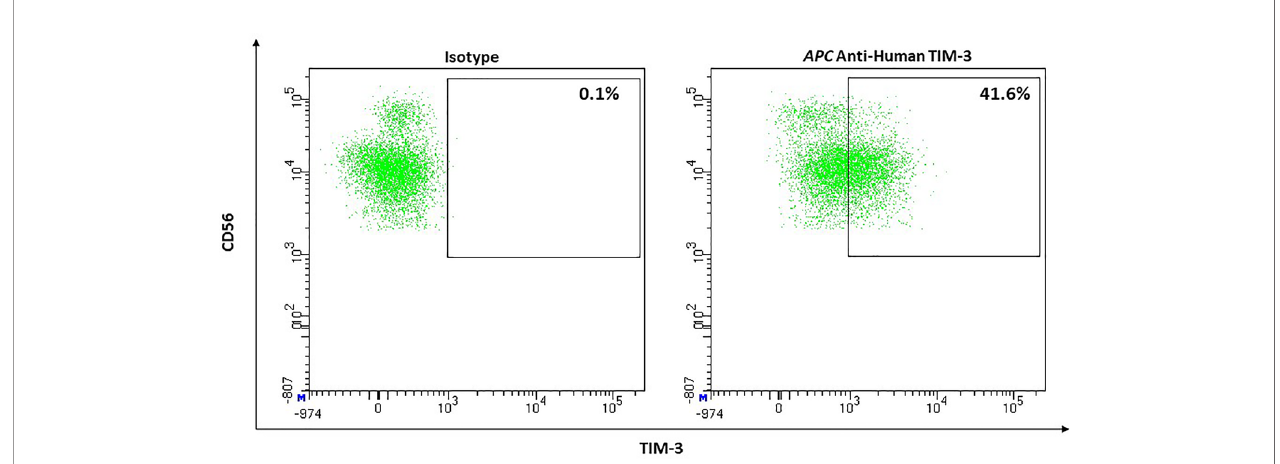
FIGURE 7 | Representative fl ow cytometric analysis of the expression of the immune checkpoint TIM-3 on resting NK cells of a healthy donor (male, 23 years old) compared with isotype